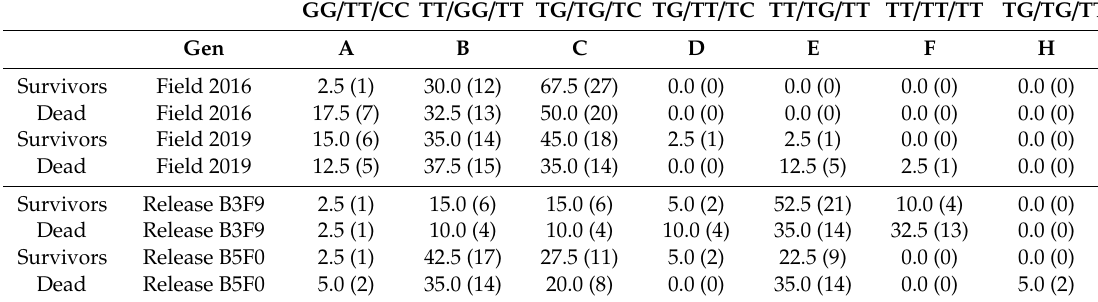
Table 1. Vssc genotypes of survivors and dead female Aedes aegypti from the field and the laboratory release colony from WHO bioassays with permethrin (0.25%) (order of mutation sites 1016 / 1534 / 989) (Field = Shah Alam 2016 pre-release and Shah Alam 2019 after release; the laboratory release colony was tested at B3F9 and B5F0).